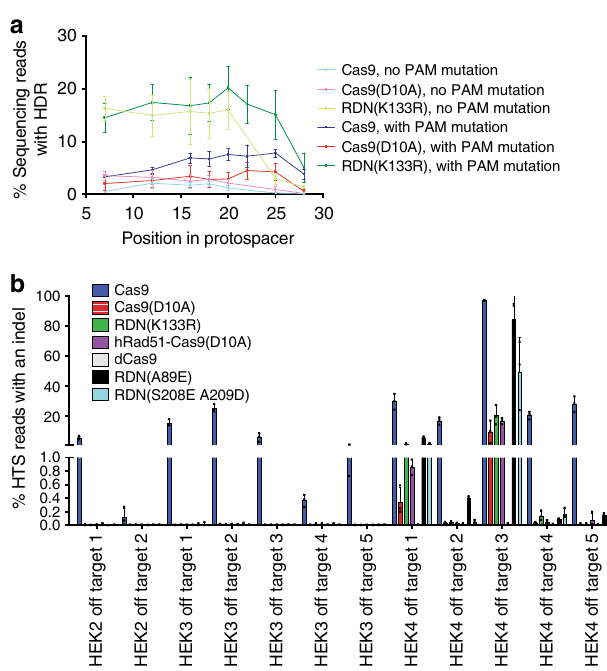
Fig. 4 Characterization of positional dependence and off-target editing of nick-mediated HDR. a HDR frequencies measured by high-throughput sequencing in unsorted HEK293T cells using ssODNs with point mutations distributed along the sgRNA protospacer sequence of the HEK 3 sgRNA site. In previous fi gures, an oligonucleotide with a different PAM-blocking mutation at HEK Site 3 was used to measure an SNP incorporated at position 12 in the protospacer. b Indel frequencies at off-target genomic loci in cells treated with Cas9 nuclease, Cas9(D10A) nickase, or Cas9(D10A) fusions with hRad51 or the indicated mutants thereof. Dead Cas9 (dCas9) treated cells were included as a negative control. All data are shown as individual data points and mean ± s.d. for n = 3 independent biological replicates, performed on different days. Source data are provided in